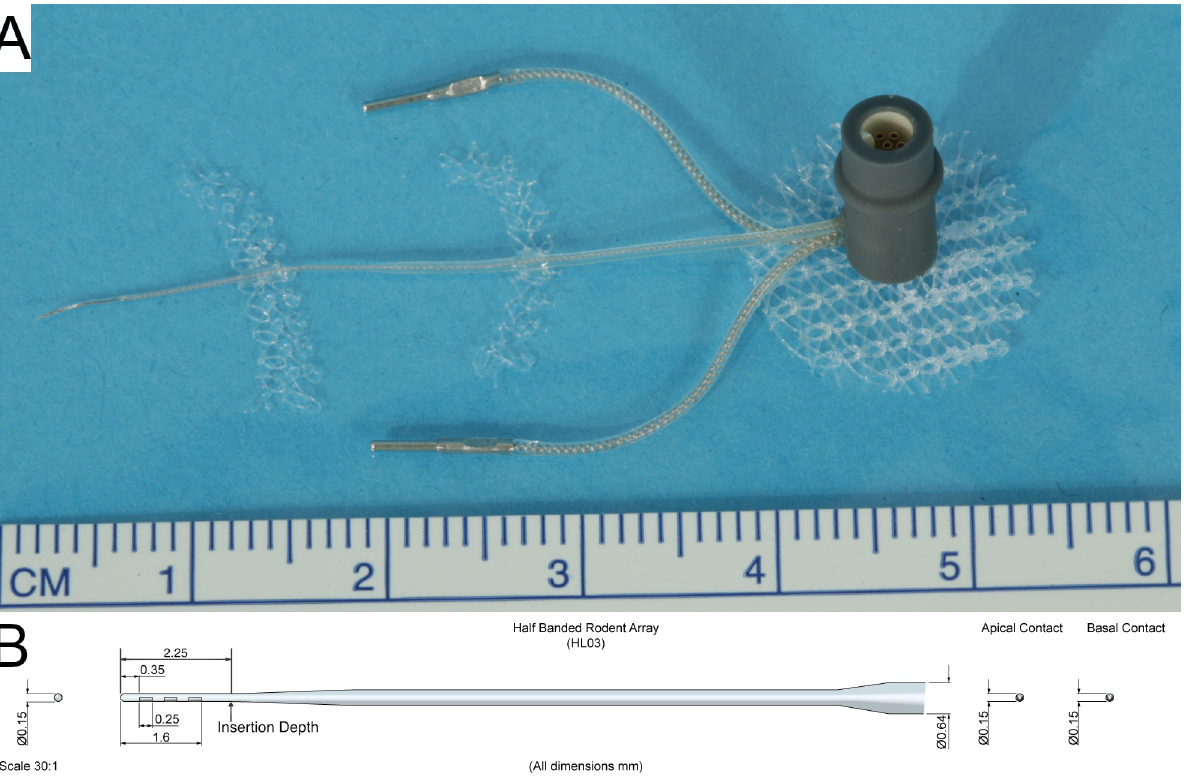
Fig 2. Electrode array assembly. The electrode array assembly (A) and schematic (B) are pictured. The electrode assembly consisted of a 2.25 mm long and 0.15 mm wide half-banded three contact electrode intracochlear array tapering to a wider extracochlear helixed lead wire with silicone insulation along with two extracochlear electrodes connected to a transcutaneous 6-pin connector. Modified polypropylene hernia mesh is affixed strategically to enable subcutaneous fixation and stabilization of the